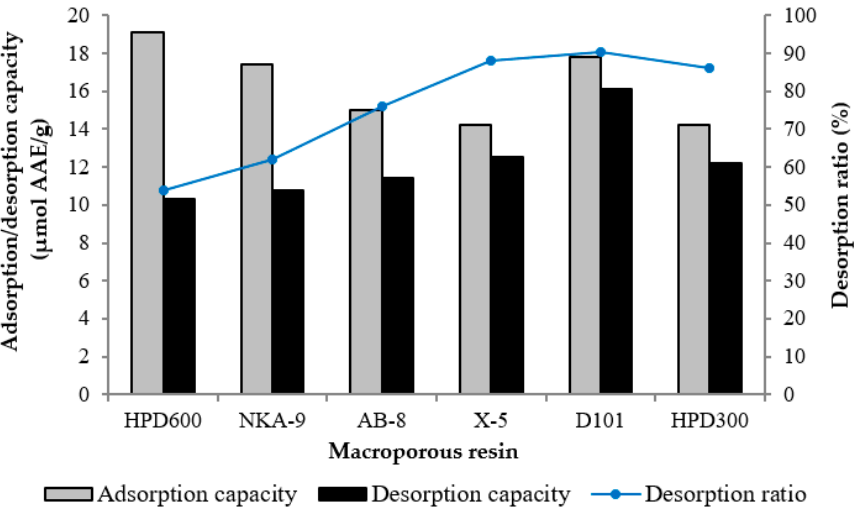
Figure 1. Adsorption, desorption capacities and desorption ratios of the antioxidants on different